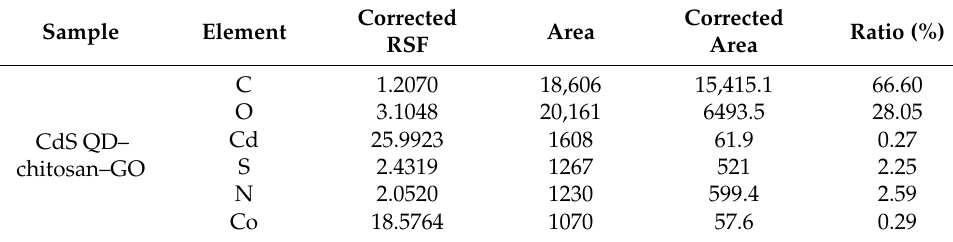
Table 6. Elemental composition of the CdS QD–chitosan–GO thin film after contact with Co 2+ .